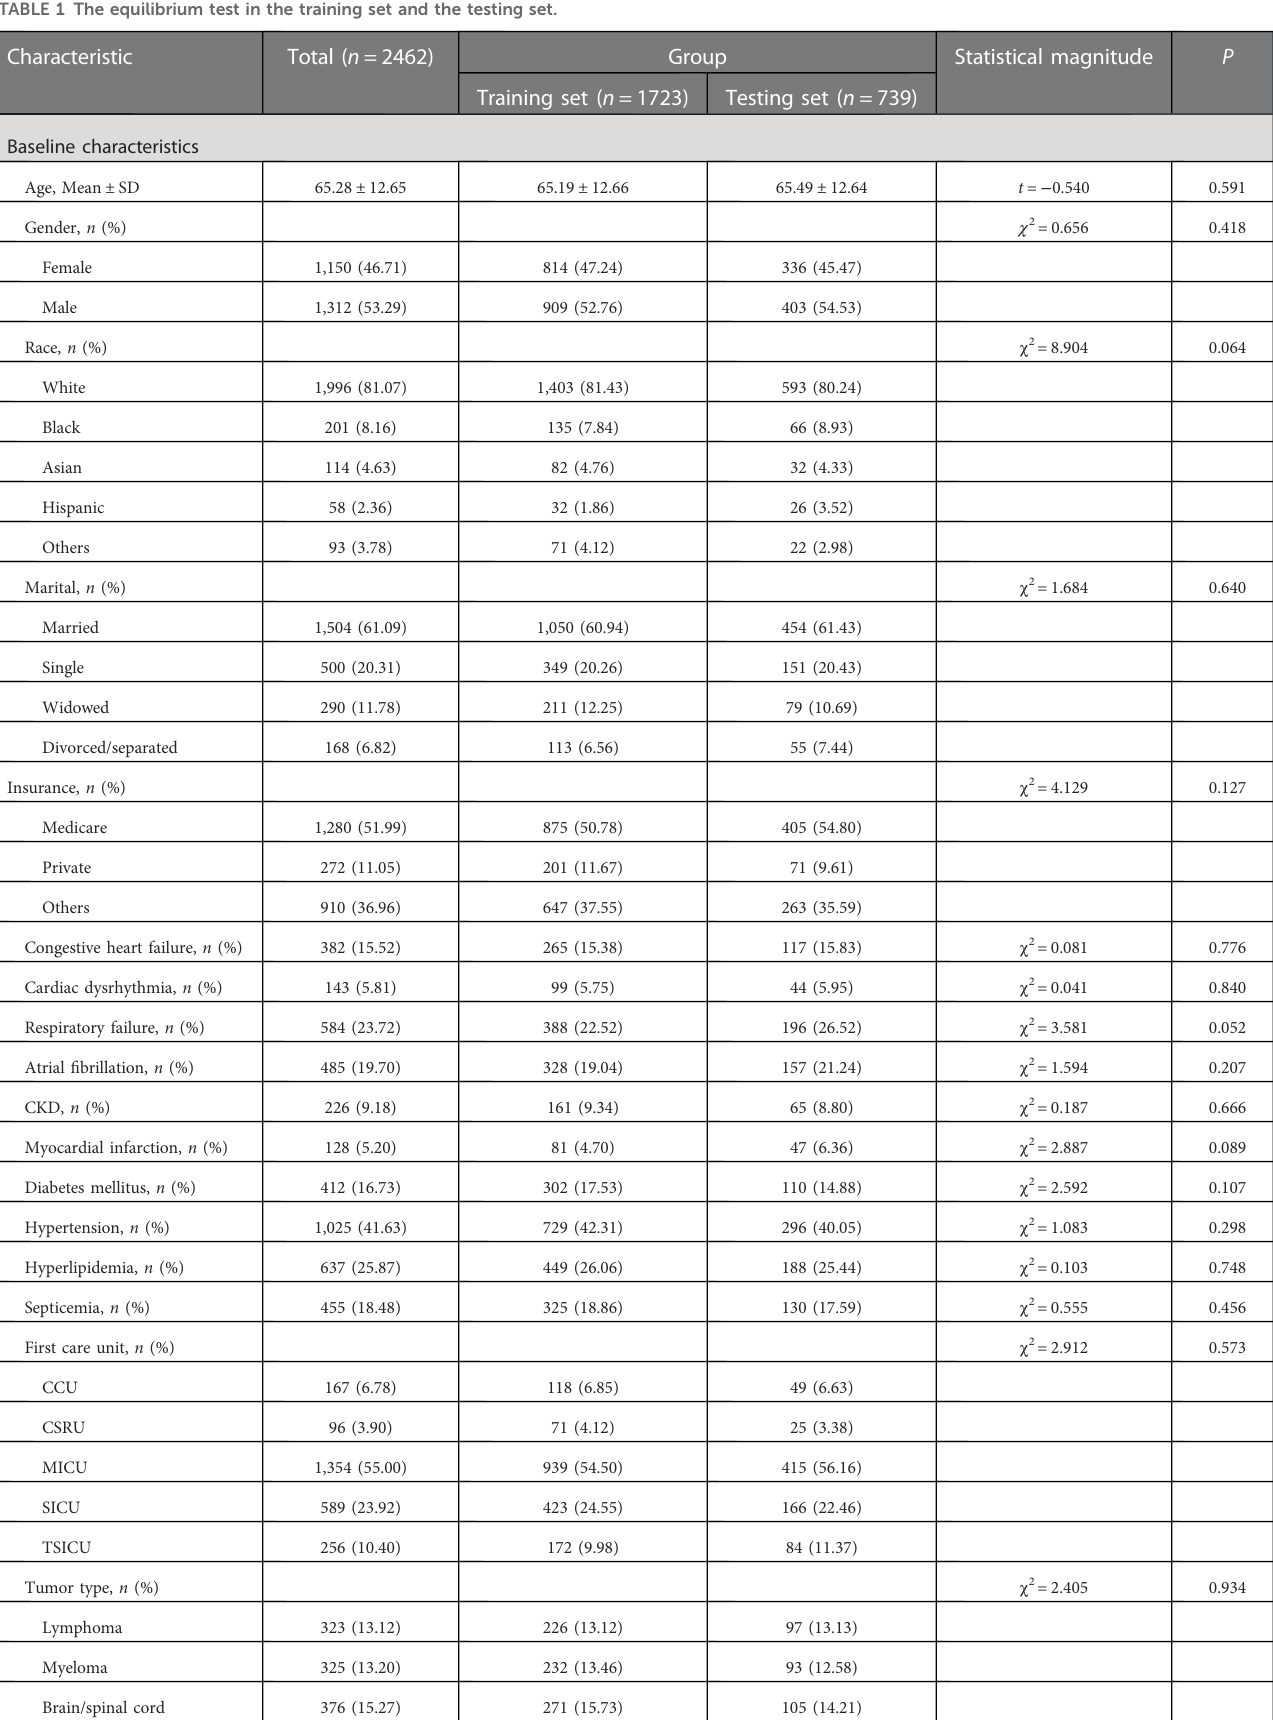
TABLE 1 The equilibrium test in the training set and the testing set. Characteristic Total ( n = 2462) Group Statistical magnitude P Training set ( n = 1723) Testing set ( n =